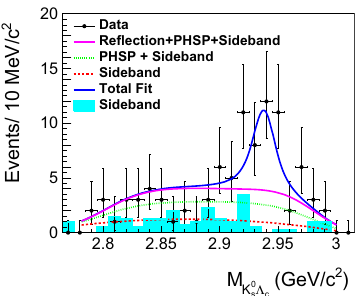
Fig. 4 The M distribution of the selected data candidates, with K 0 S (cid:4) + c fit results superimposed. Dots with error bars are the data, the solid blue line is the best fit,the solid magenta line is the total non-charged- (cid:2) ( 2930 ) backgrounds including the fitted phase space, the reflection c of the charged ¯ (cid:2) c ( 2930 ) − , and the fitted sideband shape, the dotted green line is the fitted phase space and sideband shape, the dotted red line is the fitted sideband shape, the shaded cyan histogram is from the